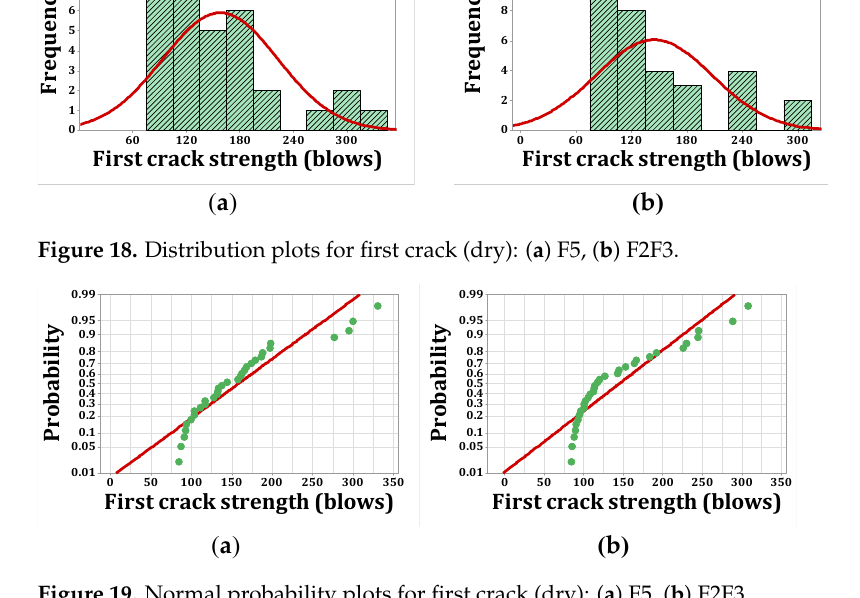
Figure 19. Normal probability plots for first crack (dry): ( a ) F5, ( b ) F2F3.